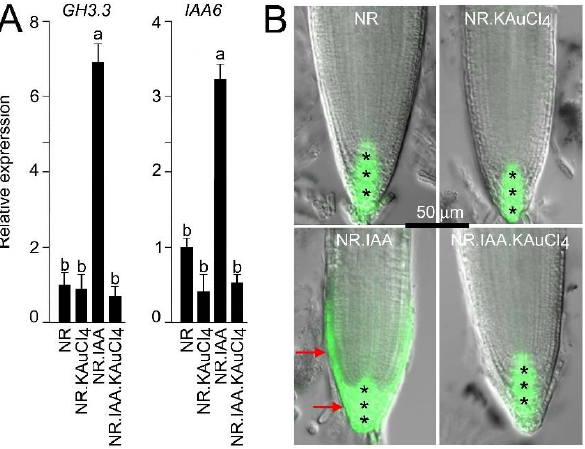
Figure 7. KAuCl 4 reinstated the IAA-mediated elevated expression of auxin-responsive genes and auxin subcellular localization in the root. Arabidopsis (wild-type and transgenic DR5rev:GFP ) seedlings were initially grown hydroponically in the NR medium for 7 d and then transferred to NR, NR.KAuCl 4 , NR.IAA, and NR.IAA.KAuCl 4 media for a further 7 d, as described in the legend to Figure 5. Root tissues of the wild-type and transgenic DR5rev:GFP seedlings were harvested for qRT-PCR and fluorescence microscopy, respectively. ( A ) The relative expression levels of GH3.3 and IAA6 in the root were determined by qRT-PCR. ACT2 was used as an internal control. Values are means ± SE ( n = 6) and different letters on the histograms indicate significant differences ( p < 0.05). ( B ) Microscopic images of the primary roots showing the effect of NR, NR.KAuCl 4 , NR.IAA, and NR.IAA.KAuCl 4 on the spatial expression pattern of the transgenic DR5rev:GFP . Asterisks (***) indicate the normal expression of DR5:GFP in the QC and columella cells. Red arrows indicate the surrounding region of the QC and columella cells where DR5:GFP expression was induced upon IAA